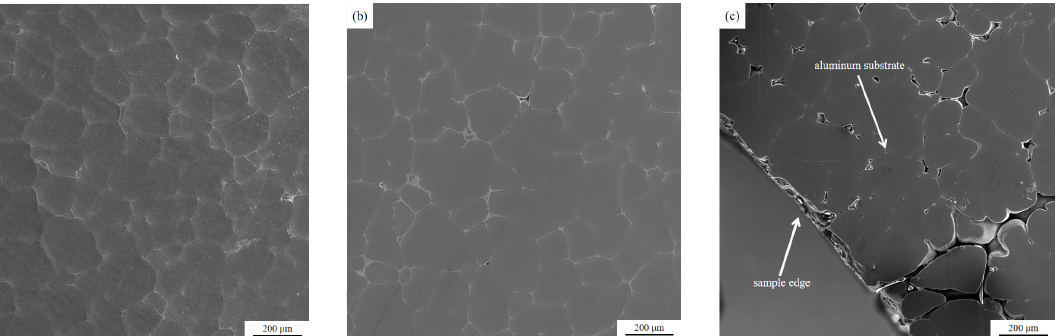
Figure 8. SEM image of the residual aluminum melt sample inside the former ceramic cavity: ( a ) central area, ( b ) transition area, ( c ) marginal area.